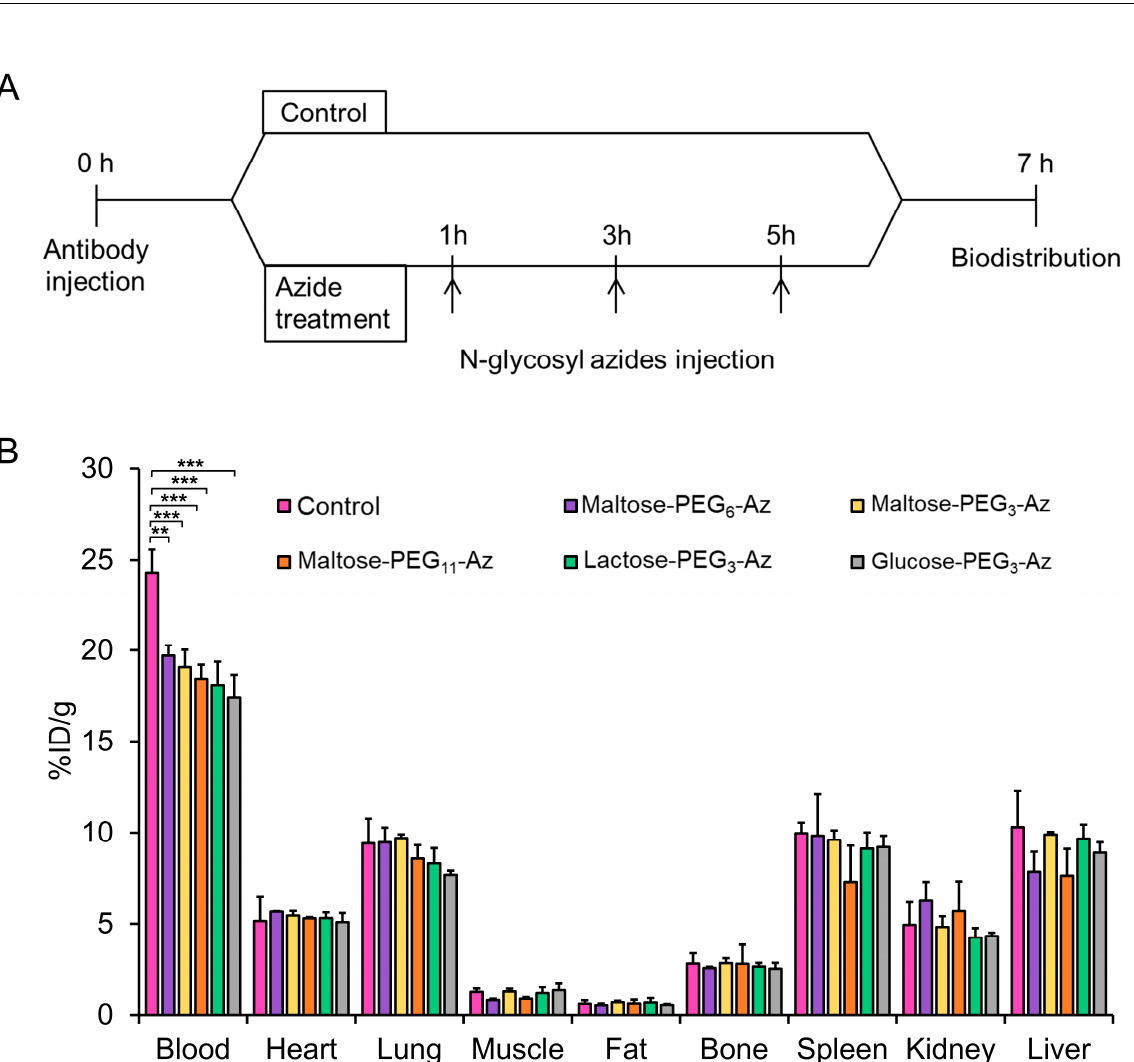
Figure 7. A schematic representation depicting the injection of radiolabeled antibody followed by sugar-azides ( A ). Biodistribution data of ICR mice demonstrating the blood pool radioactivity elimination upon reaction with the respective N-glycosyl azides (n = 3) ( B ). ** p < 0.01 and *** p < 0.001.